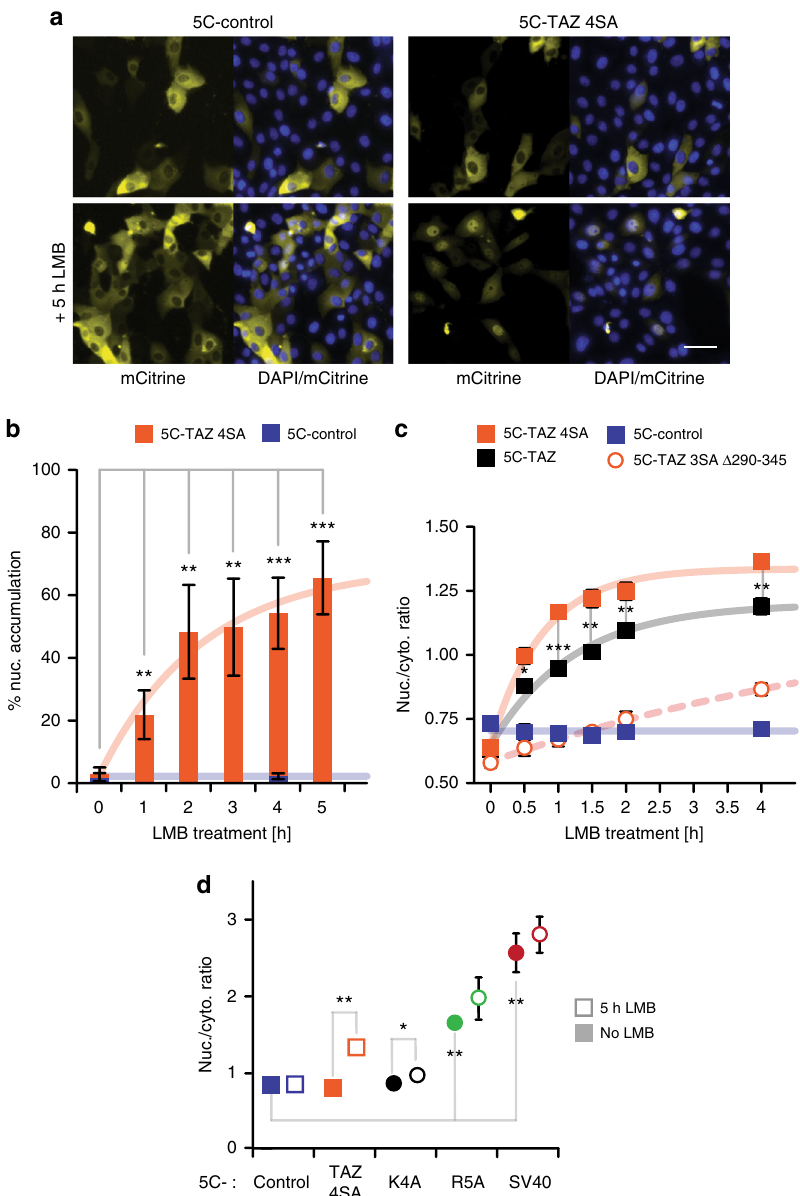
Fig. 2 Nuclear import of TAZ is a mediated process observable upon LMB treatment. a LMB dependent nuclear accumulation of 5C-TAZ 4SA. Fluorescence microscopy images of cells expressing 5C-control or 5C-TAZ 4SA, without and with 5 h LMB treatment. 5C-control localizes predominantly to the cytoplasm, independent of LMB treatment, consistent with the absence of passive in fl ux and mediated import. 5C-control, therefore, represents the negative control for nuclear localization. 5C-TAZ 4SA accumulates in the nucleus upon LMB treatment, suggesting the presence of a mediated import (and a LMB-sensitive export). Images depict mCitrine fl uorescence (yellow) and a merge of mCitrine and DAPI (blue) channels. Scale bar represents 50 μ m. b Visual quanti fi cation of nuclear accumulation. Cells expressing 5C-control or 5C-TAZ 4SA were incubated with LMB for the indicated times and nuclear accumulation was assessed by visual analysis, n = 4, 5, or 9 for individual constructs. Curve represents a fi t to an exponential rise to maximum function. For the control, no time-dependence was observed and the line depicts the overall average accumulation. c Automated quanti fi cation of nuclear accumulation. Cells expressing 5C-control, 5C-TAZ 4SA, 5C-TAZ, or a deletion construct (5C-TAZ 3SA Δ 290 – 345, introduced in the following sections), were treated with LMB for the indicated times and median R N/C values were determined, n = 3 or 4 for individual constructs. Curves and line as described in ( b ). Differences between full-length TAZ constructs (5C-TAZ 4SA, 5C-TAZ) and 5C-control and differences between 5C-TAZ 4SA and the deletion construct (5C-TAZ 3SA Δ 290 – 345) are signi fi cant at all time-points ( p < 0.01, not indicated). Asterisks indicate signi fi cant differences between 5C-TAZ 4SA and 5C-TAZ. d Median R N/C of 5C-TAZ 4SA, 5C-control, and the 5C-tag fused to the minimal SV40-NLS (residues 126 – 132) or its weaker variants (K4A, R5A), without and with 5 h LMB treatment, n = 3. Data are represented as means ± SD. * p < 0.05, ** p < 0.01, *** p < 0.001; Student ’ s t nucleus, which we termed RIS ’ N. In this system, strong the nucleus (Fig. 3c, left panel). When co-expressing the nuclear FKBP-anchor (H2B-2xFKBP-mCherry) together with 5C-FRB or 5C-FRB fused to TAZ fragment 290 – 345 (5C-FRB-290 – 345), the latter was slightly more nuclear even prior to stimulation.